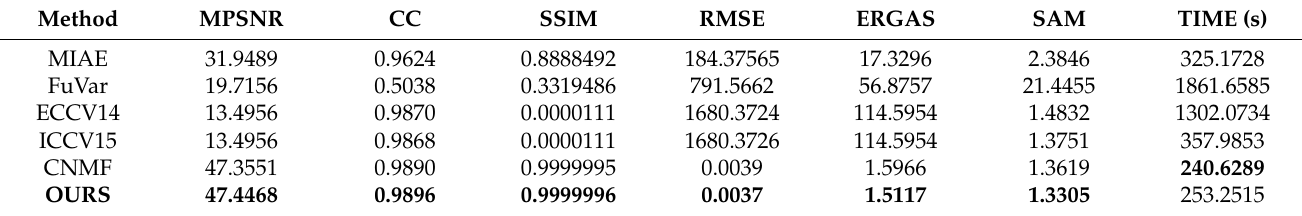
Table 1. Quantitative indices of SRR in Hyperspec Chikusei simulated